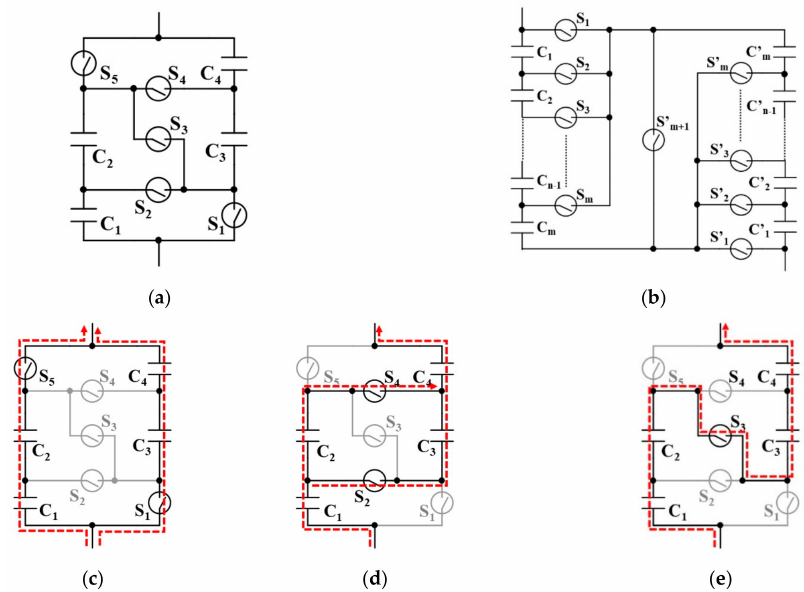
Figure 7. Unbalance-shift circuit for ( a ) four cells and ( b ) 2 m cells. Operation modes of unbalance-shift circuit for four cells; ( c ) 2S-2P, ( d ) 3S, and ( e )